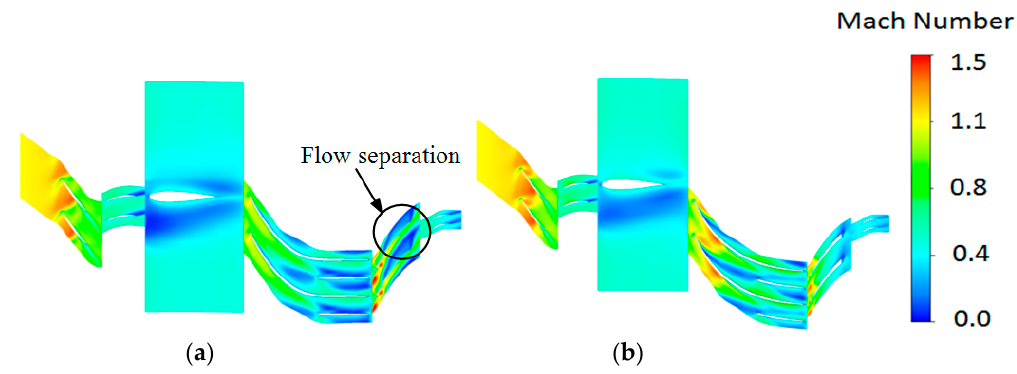
Figure 15. Design point Mach number distribution (95% blade span): ( a ) baseline; ( b ) optimized.